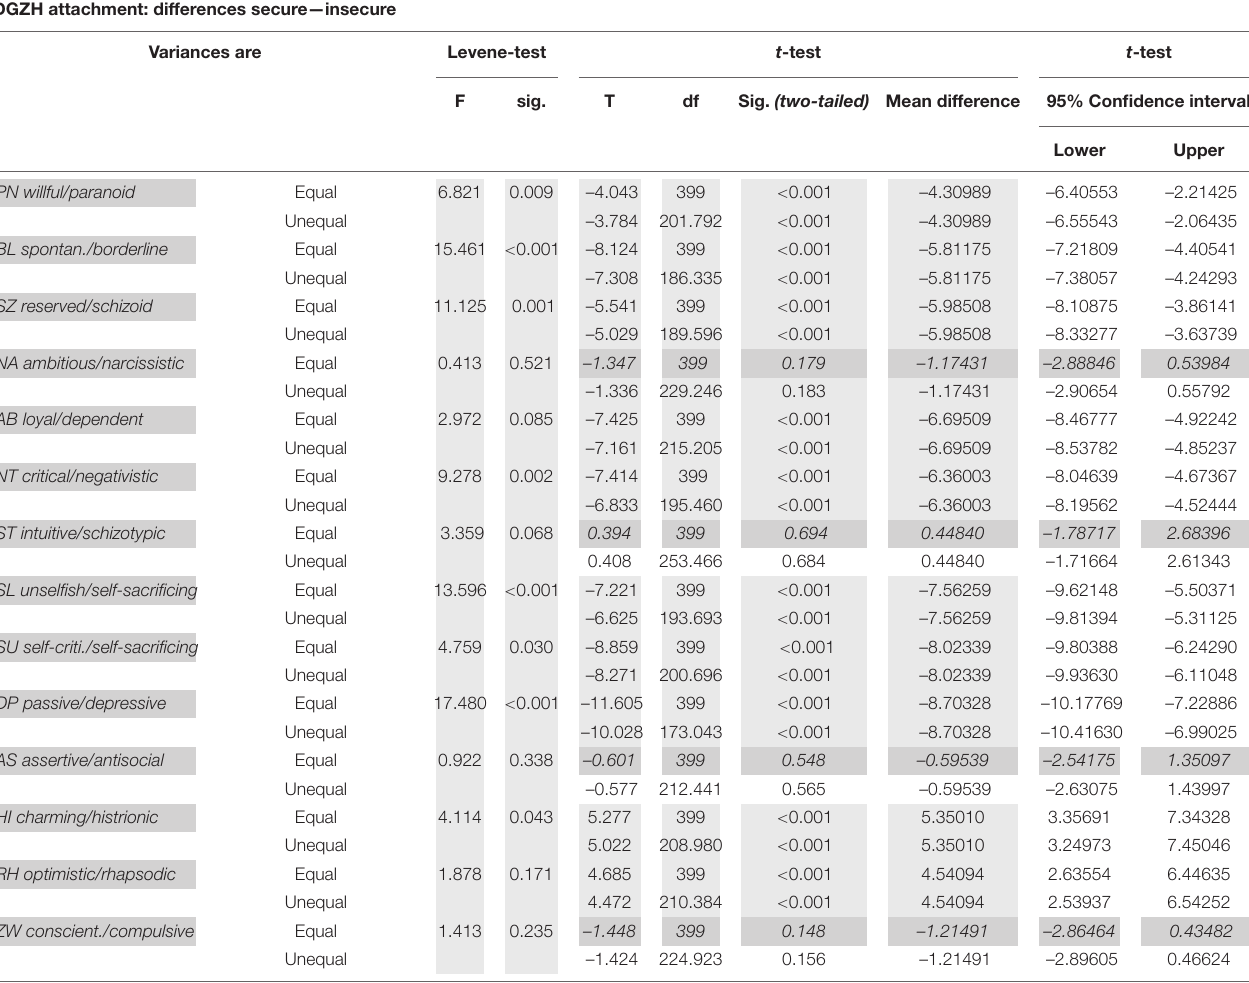
TABLE 2 | Test statistics for differences between 278 securely and 123 insecurely attached HYP DGZH dentists in 14 personality styles of the PSDI. DGZH attachment: differences secure—insecure Variances